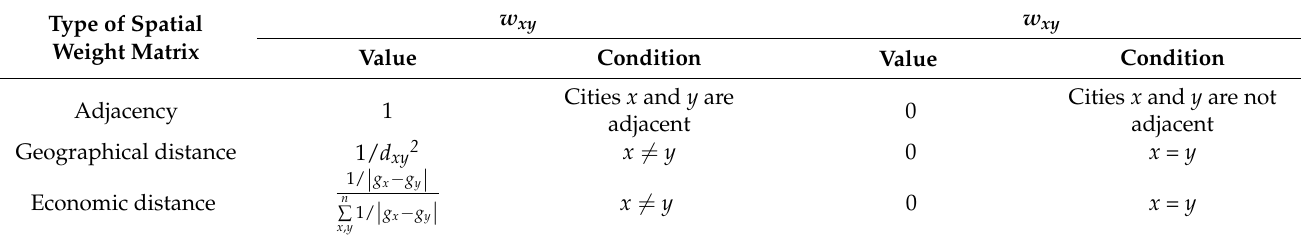
Table 1. Spatial weight matrix